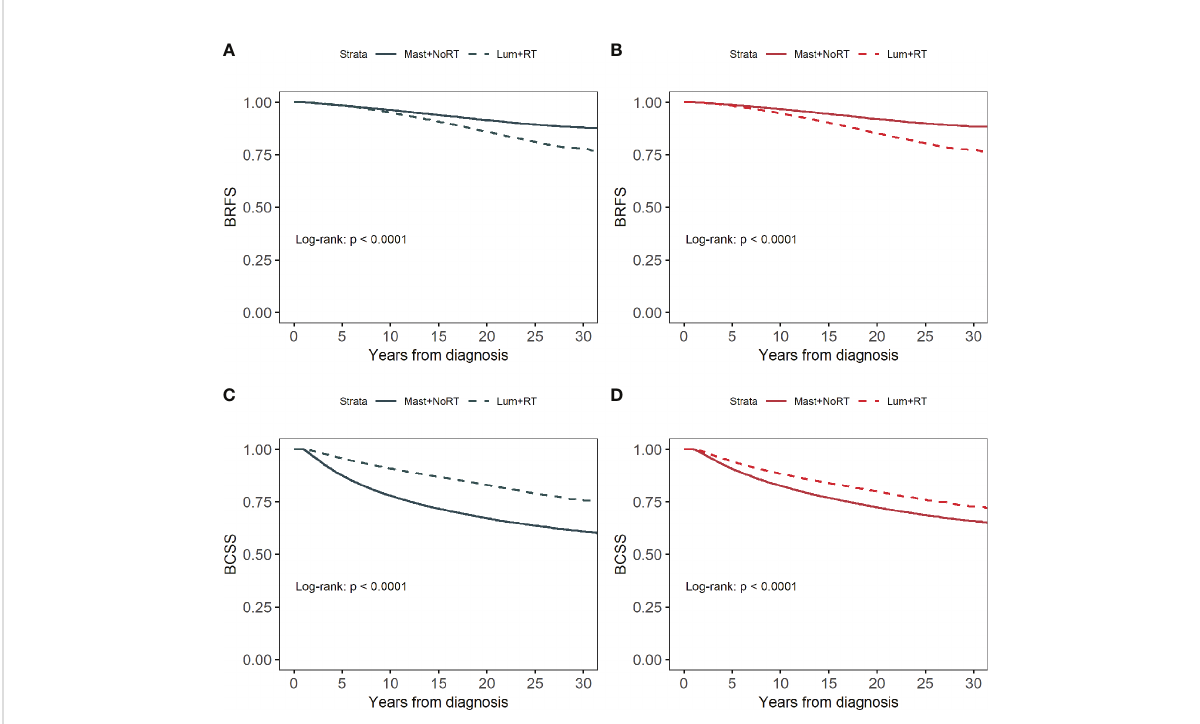
FIGURE 2 Kaplan – Meier curves for breast cancer recurrence-free survival (BRFS) by treatment before (A) and after (B) propensity score weighting. Kaplan – Meier curves for breast cancer-speci fi c survival (BCSS) by treatment before (C) and after (D) propensity score